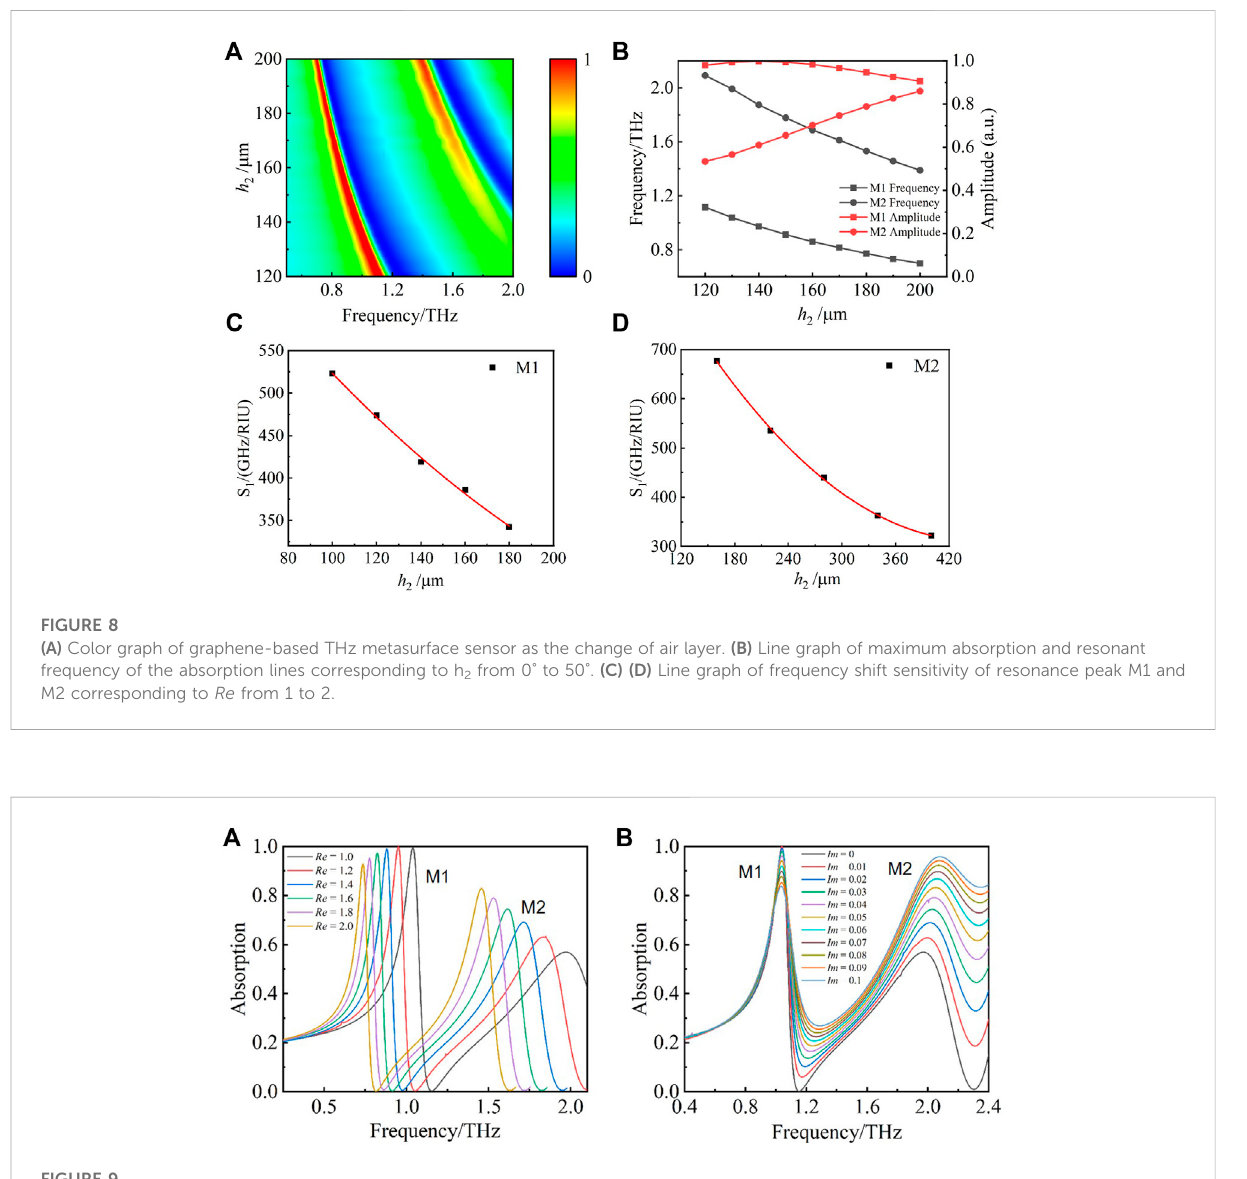
FIGURE 9 (A) Absorptionlines ofthe graphene-based THz metasurface sensor when h 2 (cid:1) 130 μ m corresponding to Re from 1to 2. (B) Absorptionlines of the graphene-based THz metasurface sensor when h 2 (cid:1) 130 μ m corresponding to Im .